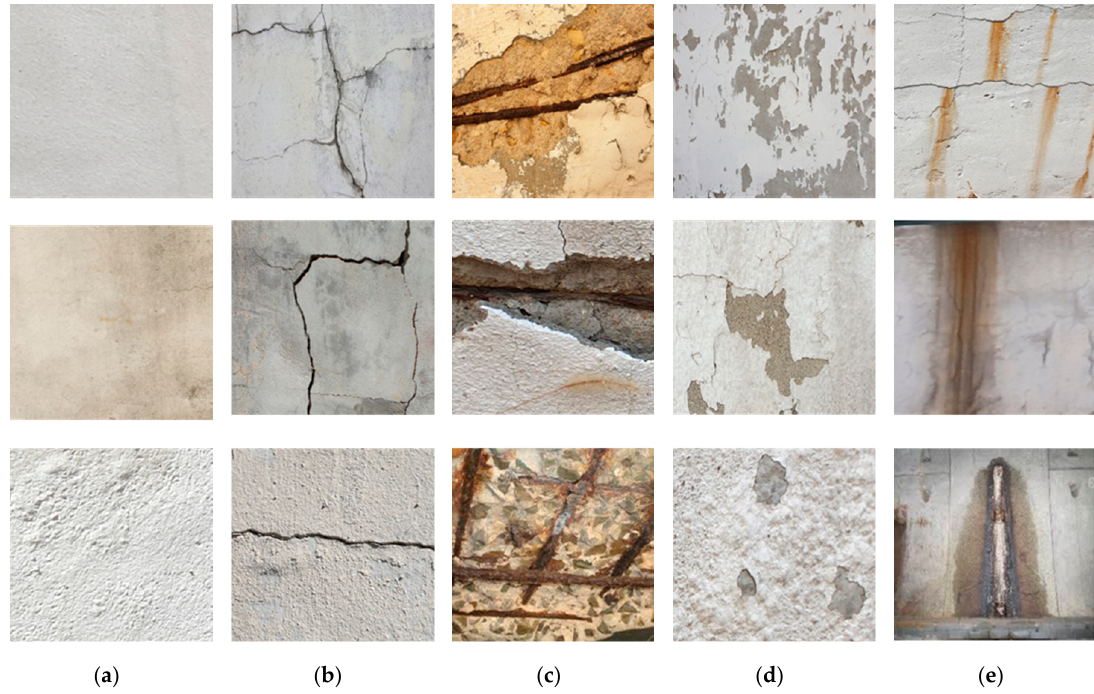
Figure 5. Examples of concrete damage. (a) Intact; ( b ) Crack; ( c ) Rebar exposure; ( d ) Delamination; ( e ) Leakage.